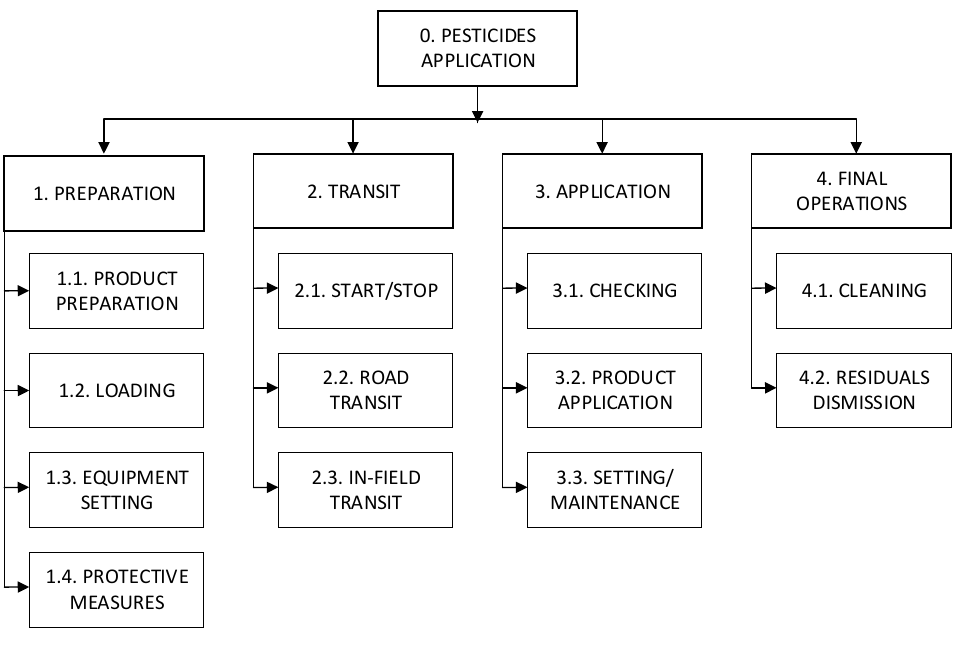
Figure 3. Scheme of the HTA application. Table 3. Excerpt of the hierarchical decomposition in the list of sub-tasks, elementary tasks and specific